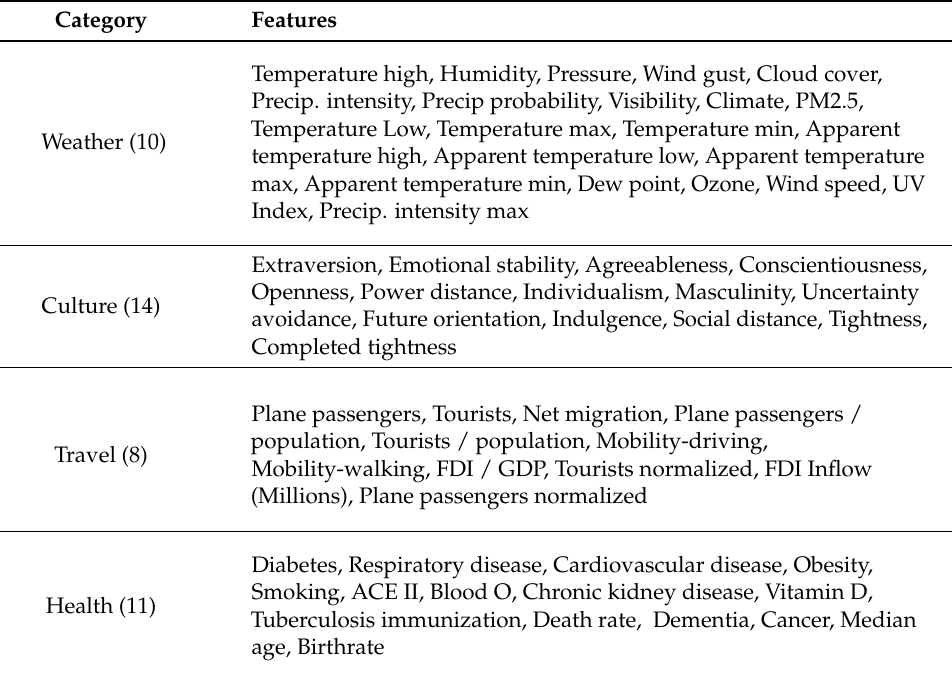
Table 4. All features, divided into different categories. Features highly correlated inside their group are grayed out. The number of features for each category is given in